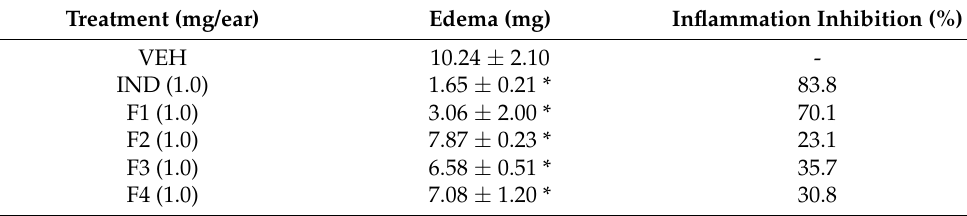
Table 2. Effect of the extract and fractions from A. angustifolia on TPA-induced ear edema. Treatment (mg/ear)